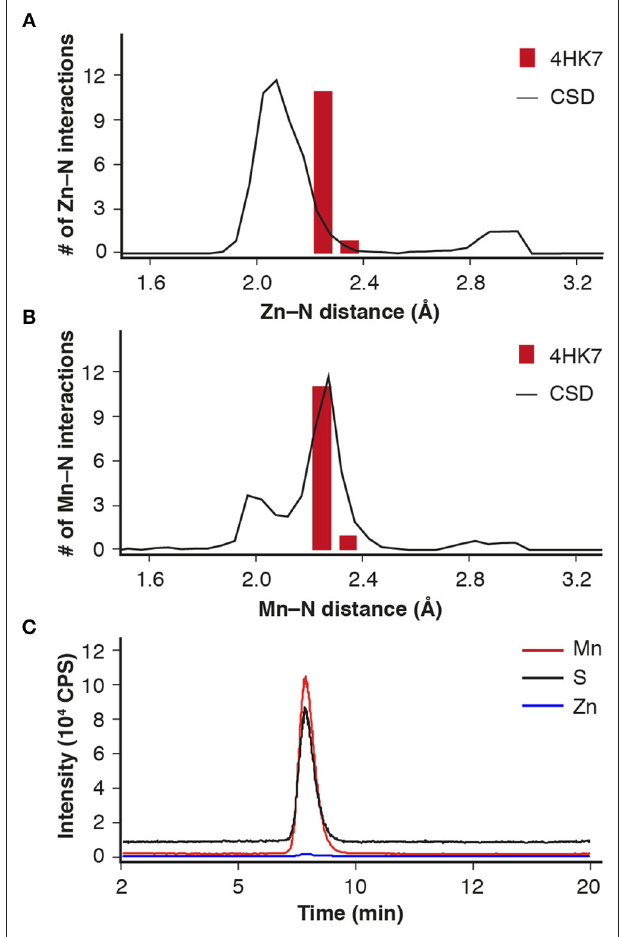
FIGURE 1 | Metal-ligand distance (red bars) for IDCase (PDB 4HK7) with (A) Zn 2 + and (B) Mn 2 + in the active site compared with database likelihoods (CSD); (C) ICPMS/MS analysis of metal ions (Mn 2 + and Zn 2 + ) in IDCase (sulfur determination for quantitative analysis of